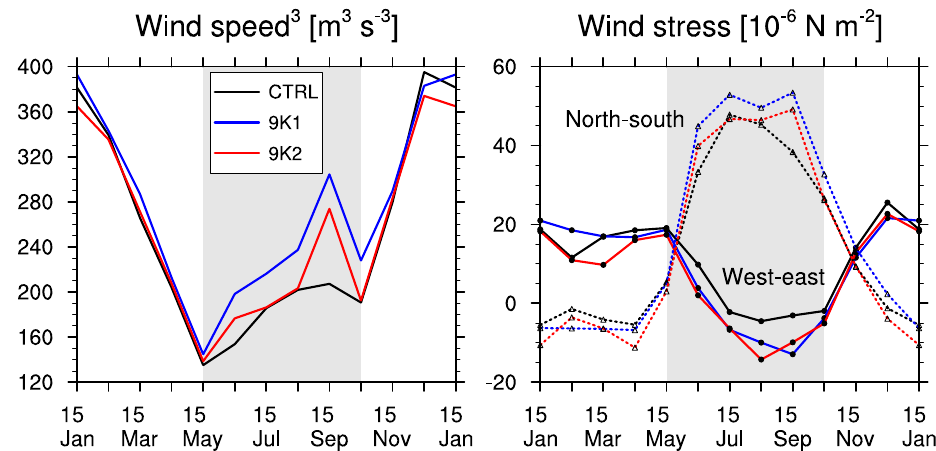
Fig. 13. Monthly climatology of wind components averaged over the Aegean/West Levantine regions for CTRL (black), 9K1 (blue) and 9K2 (red). Left panel shows 10-m wind speed cubed, the cubed value is considered because it is proportional to mixing strength. Right panel shows both west-east and north-south wind stress components. The shading represents the time period, when modelled Etesian winds are active.